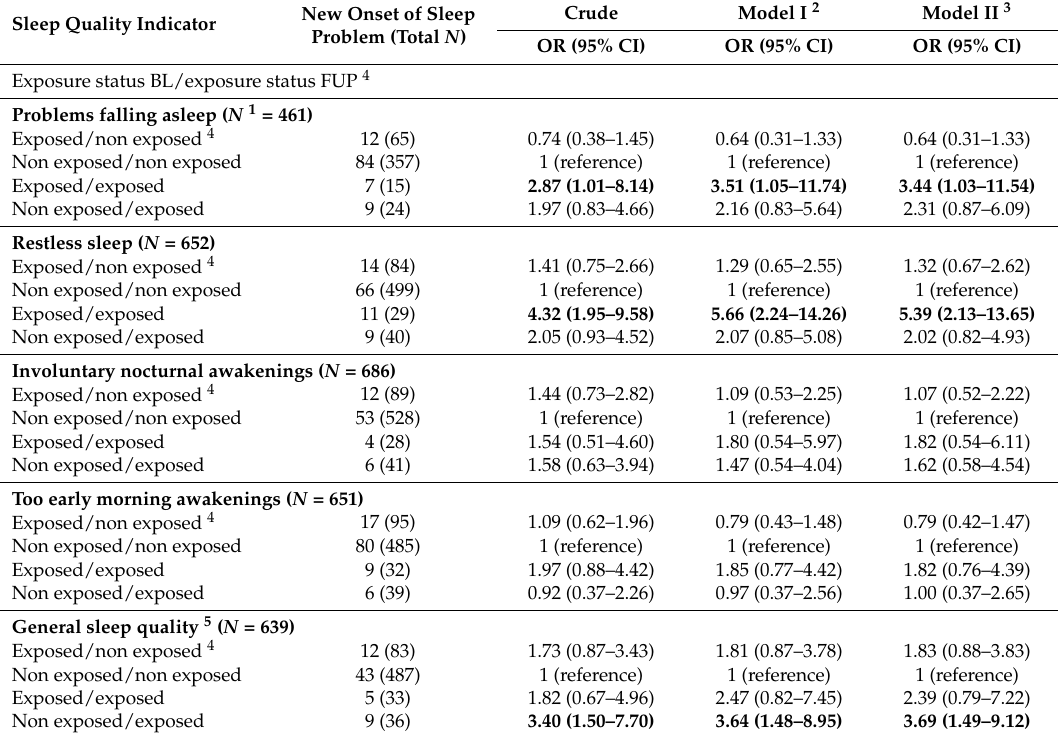
Table 2. Odds ratio (OR) to develop impaired sleep quality between BL and FUP in relation to nocturnal awakenings due to incoming mobile phone calls or text message. Significant associations are displayed in